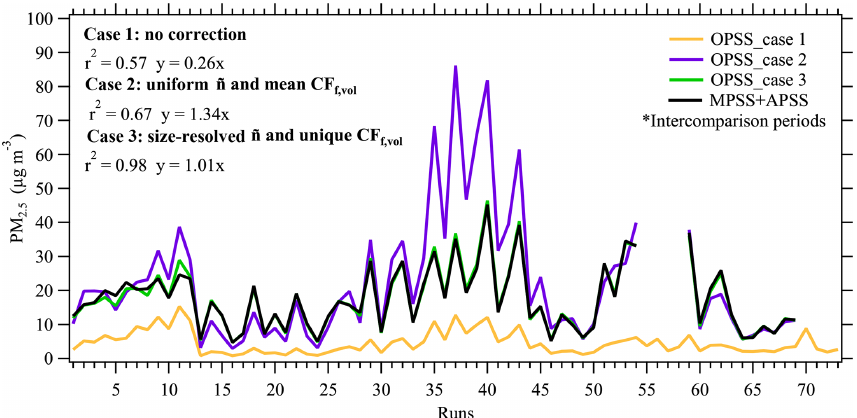
Figure 13. Illustration of the impact of data correction on the uncertainties of the PM 2 . 5 from OPSS.